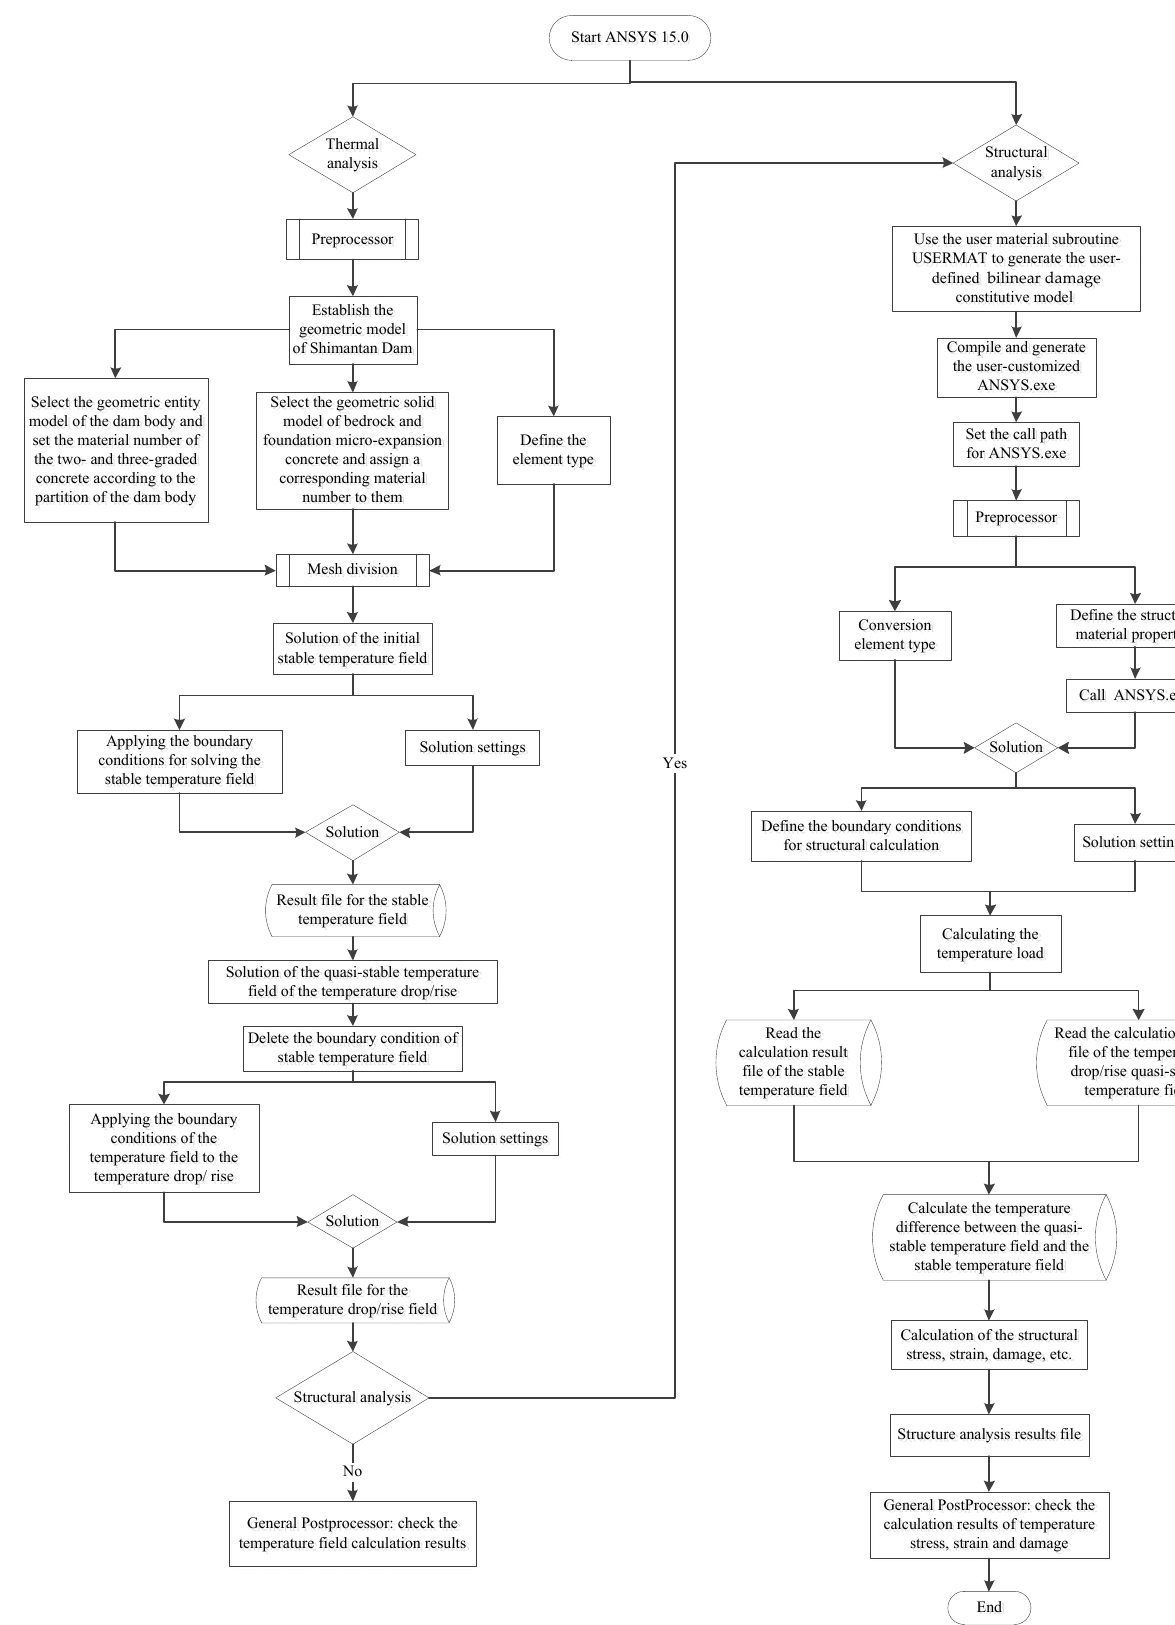
Figure 12. The flow chart of macro model calculation.